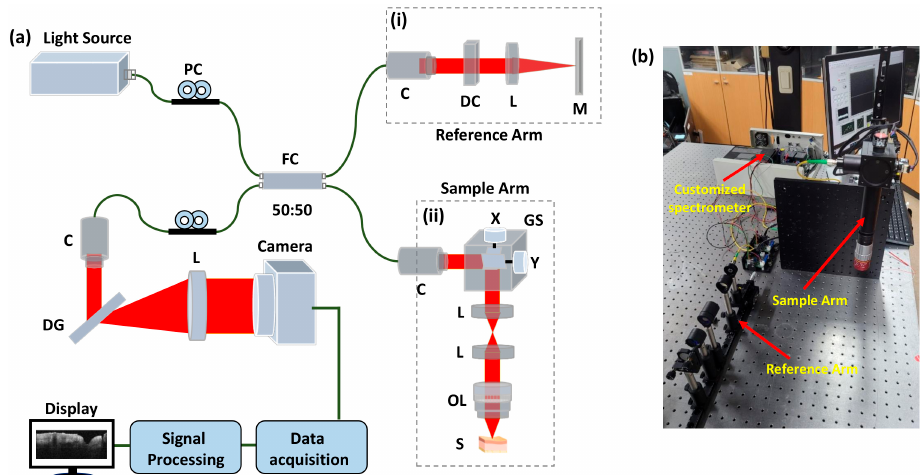
Figure 1. ( a ) Schematic diagram of high lateral resolution spectral-domain optical coherence tomography system and ( b ) a photograph of the used OCT system. C: collimator, DC: dispersion compensation unit, DG: diffraction grating, FC: fiber coupler, GS: galvanometer scanner, L: focusing lens, M: mirror, OL: objective lens, PC: polarization controller, S: sample.